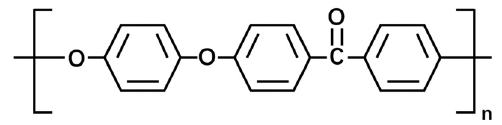
Figure 1: The chemical structural formula